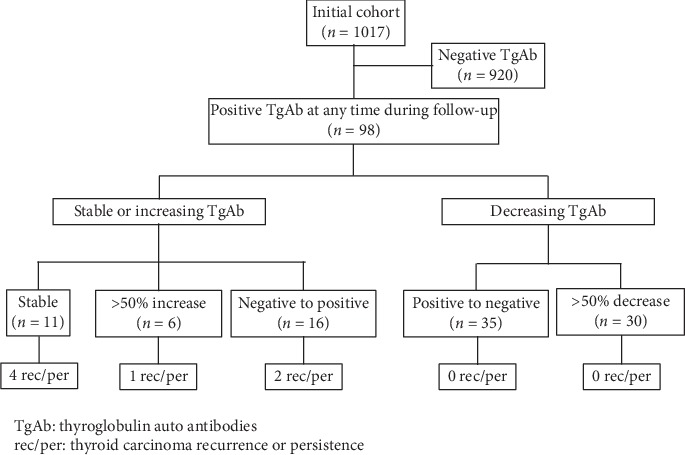
Flow chart of the study population and results.